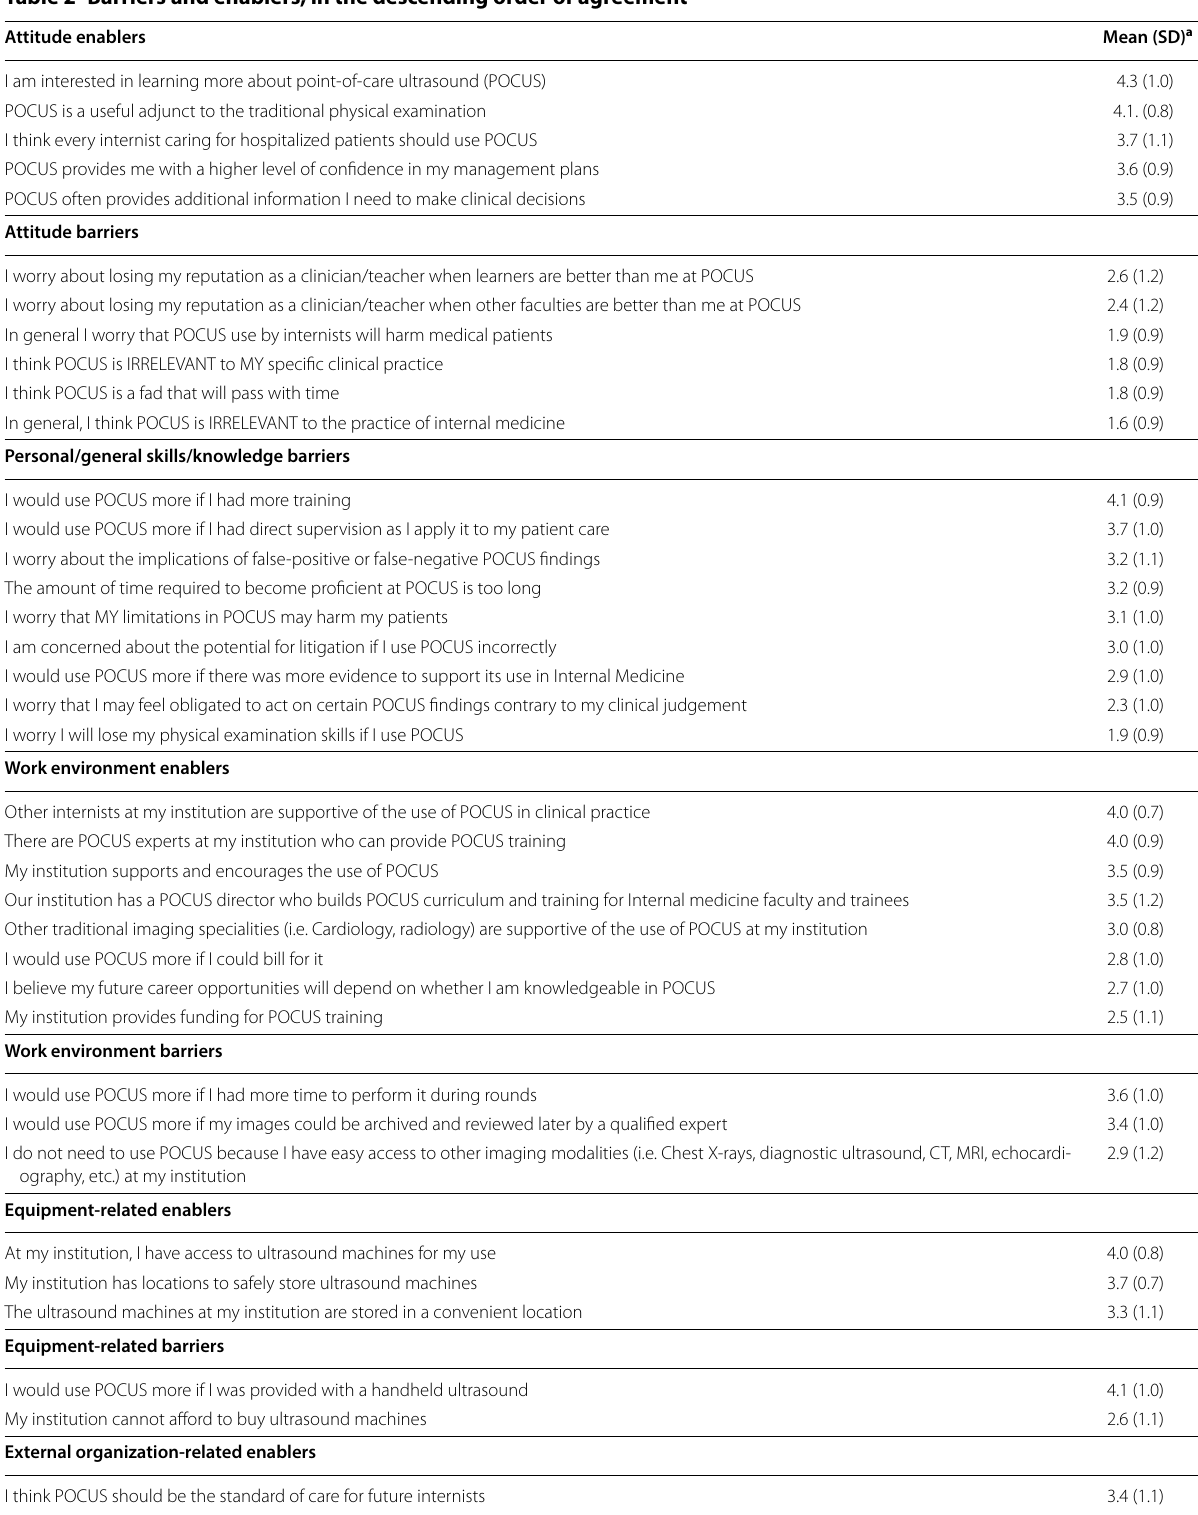
Table 2 Barriers and enablers, in the descending order of